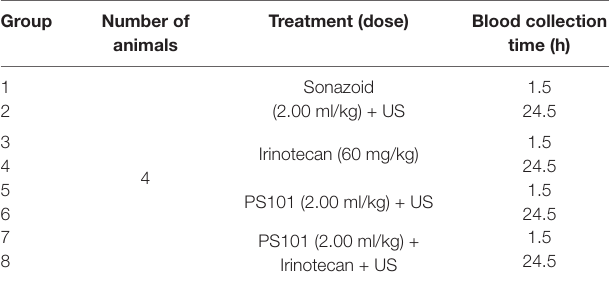
TABle 2 | Summary of the liver toxicity study groups. group number of